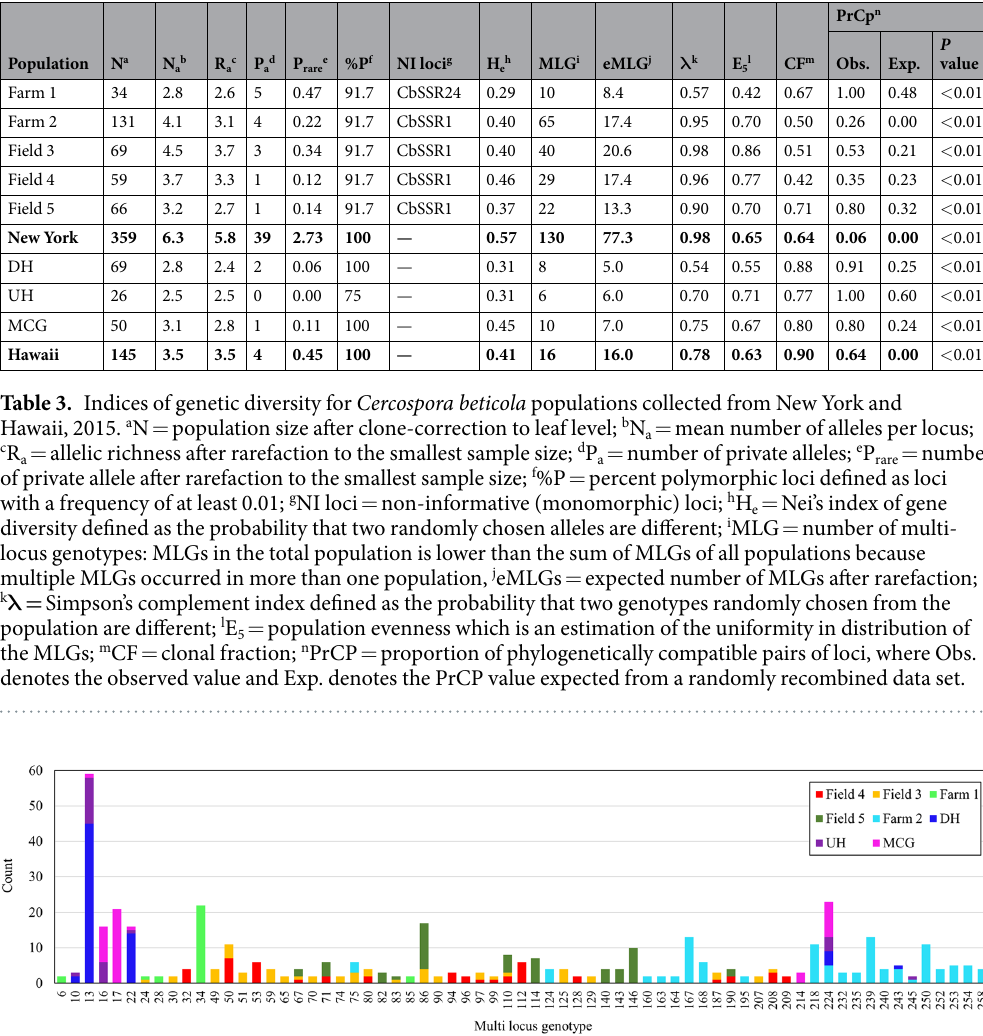
Figure 3. Recurrent multi-locus genotypes and their frequency in Cercospora beticola populations from New York (Farm 1, Farm 2, Field 3, Field 4 and Field 5) and Hawaii (MCG = Manoa community garden, UH = University of Hawaii organic garden, and DH = Diamond Head community garden),